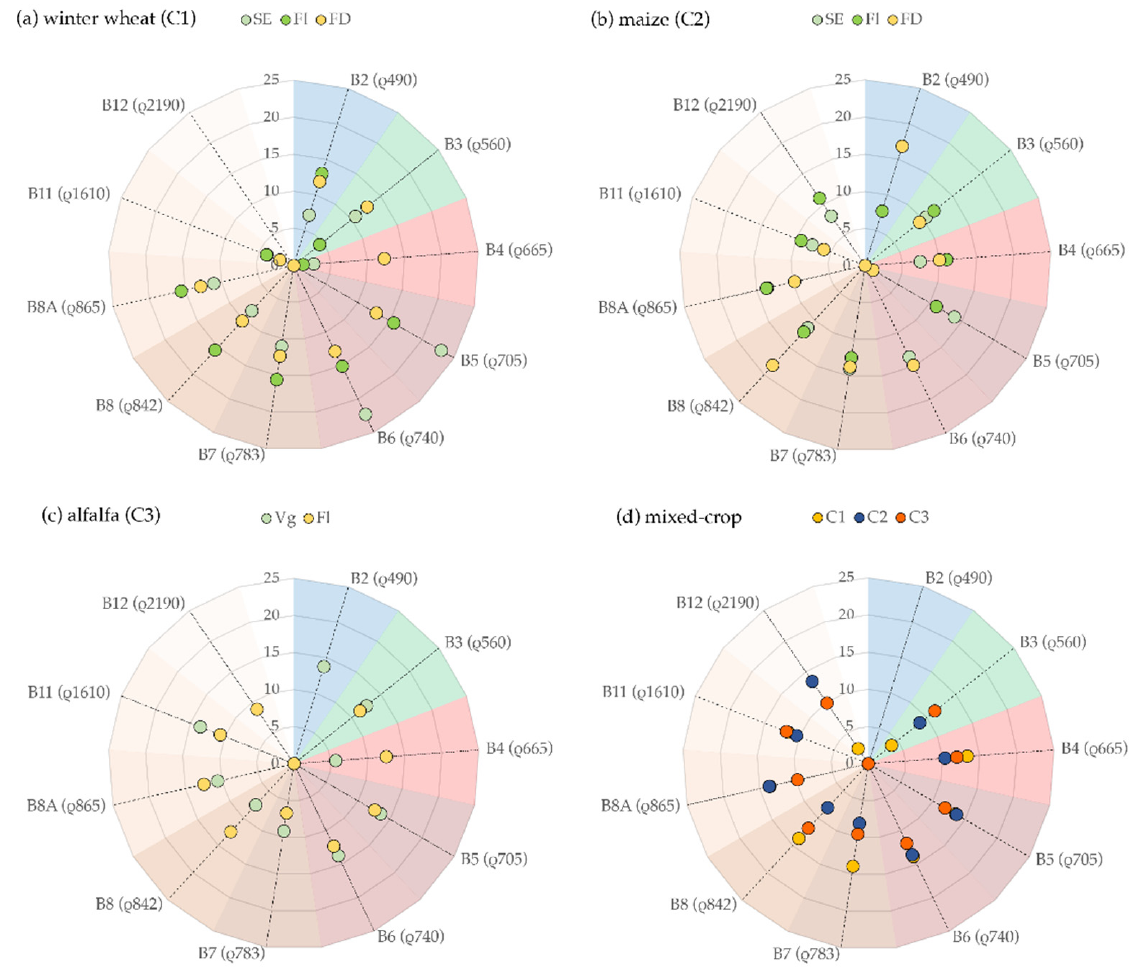
Figure 6. Radar plots of the relative weight (%), estimated from σ values provided by GPR analysis, of Sentinel-2 spectral bands to LAI estimation, according to: (i) different growing stages within the crop-specific data set for C1 (winter wheat), C2 (maize), and alfalfa (C3); and (ii) crop type within the mixed-crop data set. The growing stages for winter wheat and maize are: GE, from germination to emergence; SE, stem elongation; Fl, flowering; and FD, fruit development. For alfalfa, the growing stages were: Vg, vegetative; and Fl, flowering.